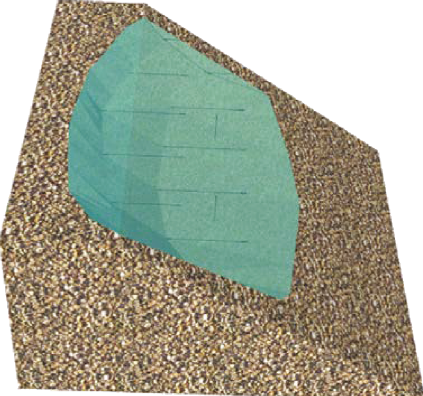
Figure 17: Three-dimensional schematic diagram of the sliding